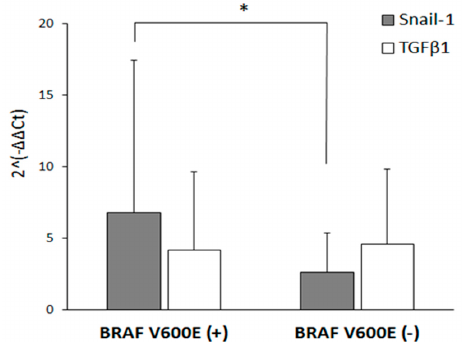
Figure 3. The expression of Snail-1 is correlated with the presence of B-type Raf kinase gene (BRAF) V600E mutation in PTC samples. The gene expression was evaluated by quantitative RT-qPCR in BRAFV600E ( + ) ( n = 30) and BRAFV600E ( − ) ( n = 31) PTC groups. The relative mRNA level was normalized to GAPDH. The results are presented as the mean of three independent experiments ± SD. * p <